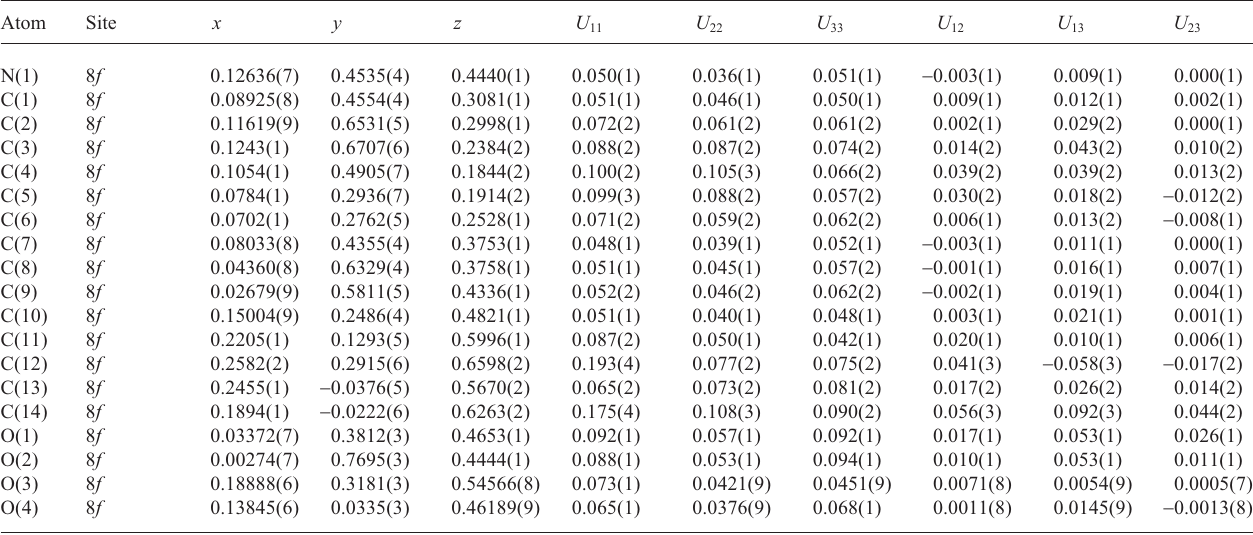
Table 3. Atomic coordinates and displacement parameters (in Å 2 )